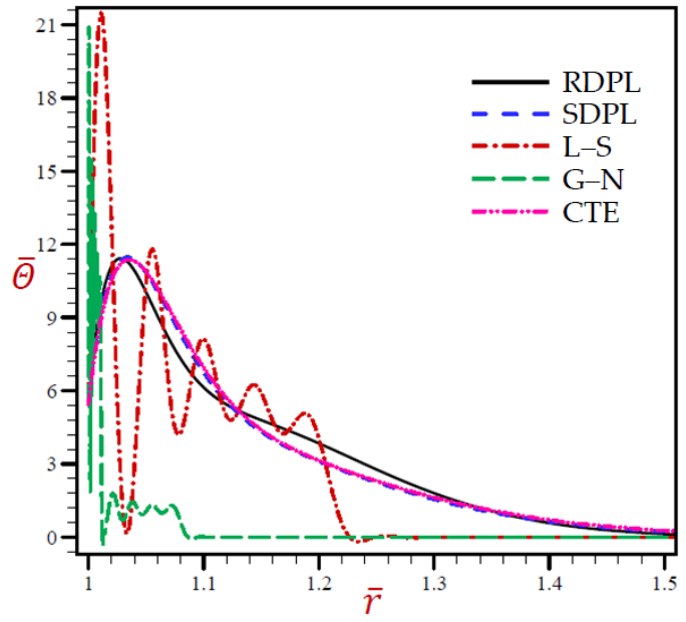
Figure 2. The temperature Θ through radial direction of spherical hole presenting to all models.